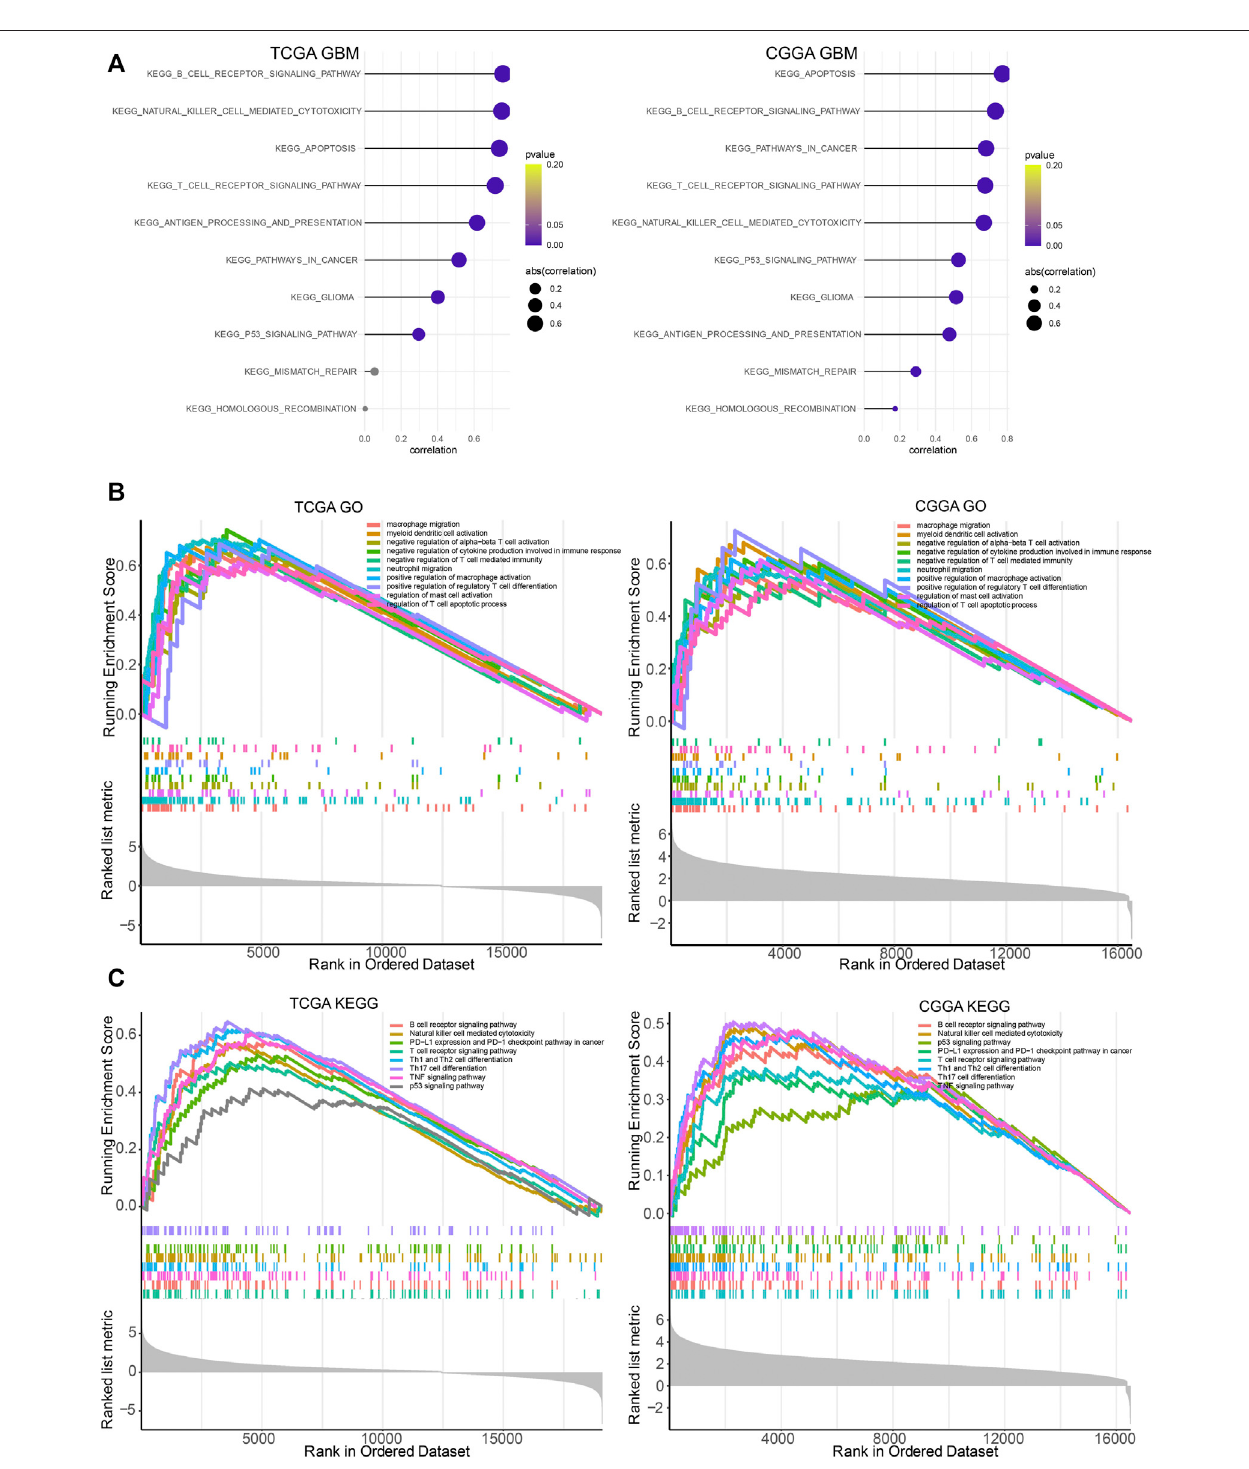
FIGURE8 | LYN related immune processes (A) .The correlation between LYN and immune related signaling pathways inTCGA GBM and CGGA GBM samples in KEGG analysis (B) . GSEA of LYN in TCGA and CGGA in GO (C) . GSEA of LYN in TCGA and CGGA in KEGG.